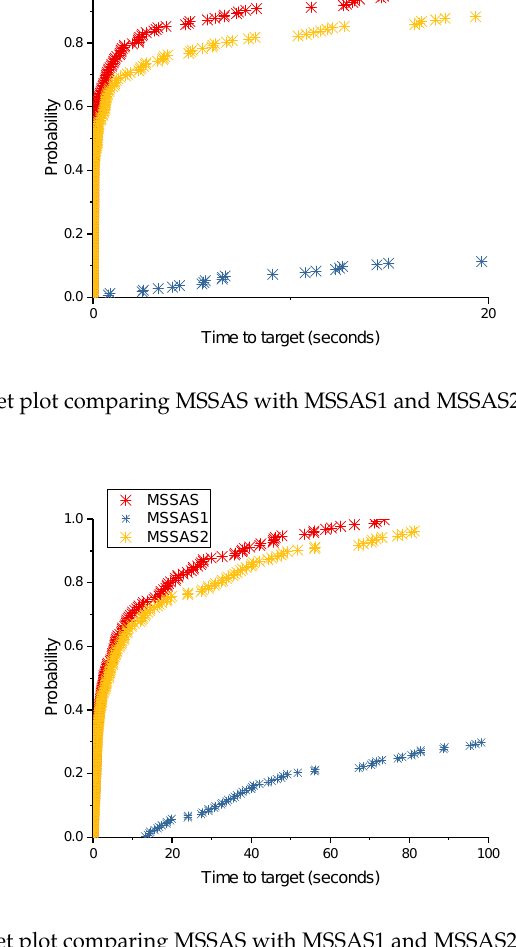
Figure 3. Time-to-target plot comparing MSSAS with MSSAS1 and MSSAS2 on instance frb30-15-1 and its target